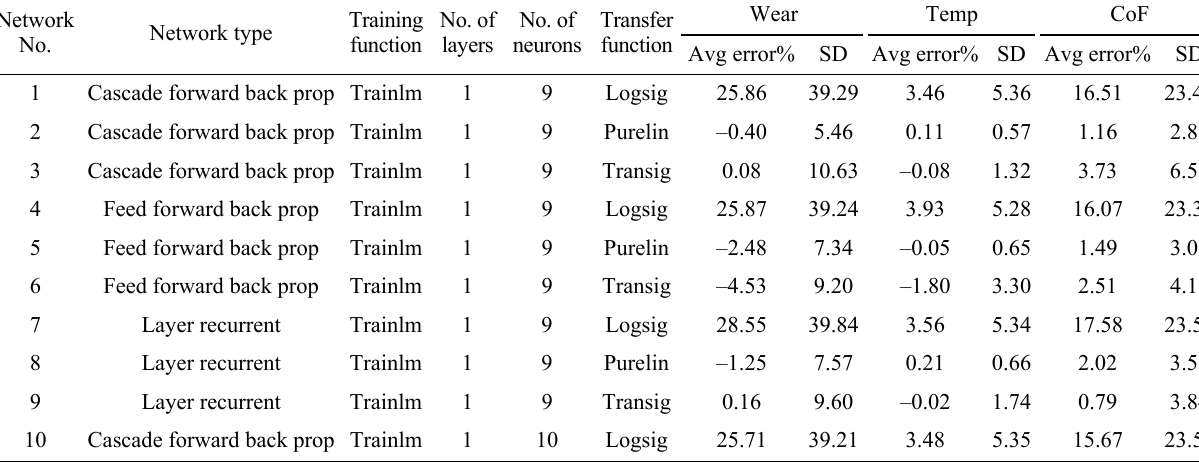
Table 16 Optimizing the transfer function in single hidden layer with 9 and 10